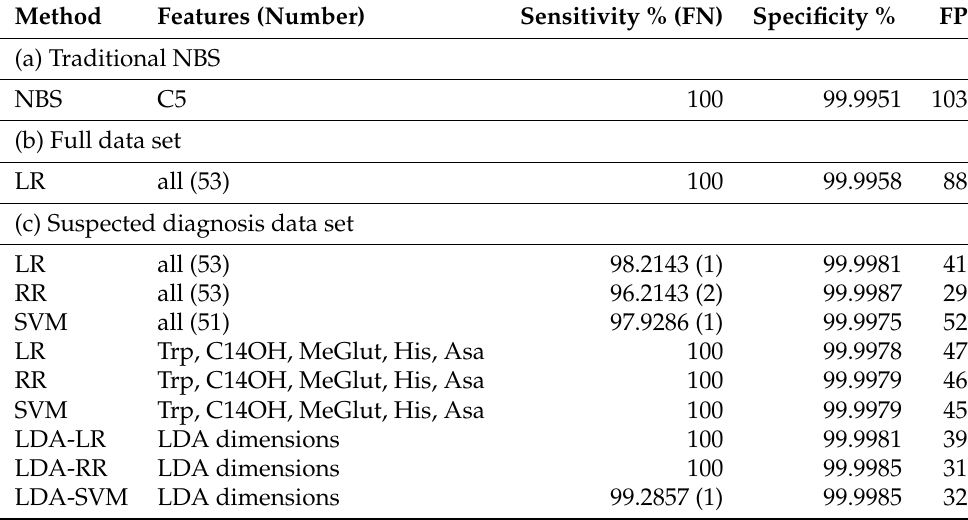
Table 4. Mean results of ten repeats of 5-fold cross-validation on (b) the full data set and (c) suspected diagnosis data set, compared to traditional screening results (a). Methods are applied to all 53 features, 5 features selected with ANOVA or LDA dimensions. The methods were evaluated by sensitivity, specificity, and number of false positives (real numbers are rounded up) combined for training and test set. For the suspected diagnosis data set, these evaluations are calculated based on the full data set to allow comparability between both data sets. Abbreviations: